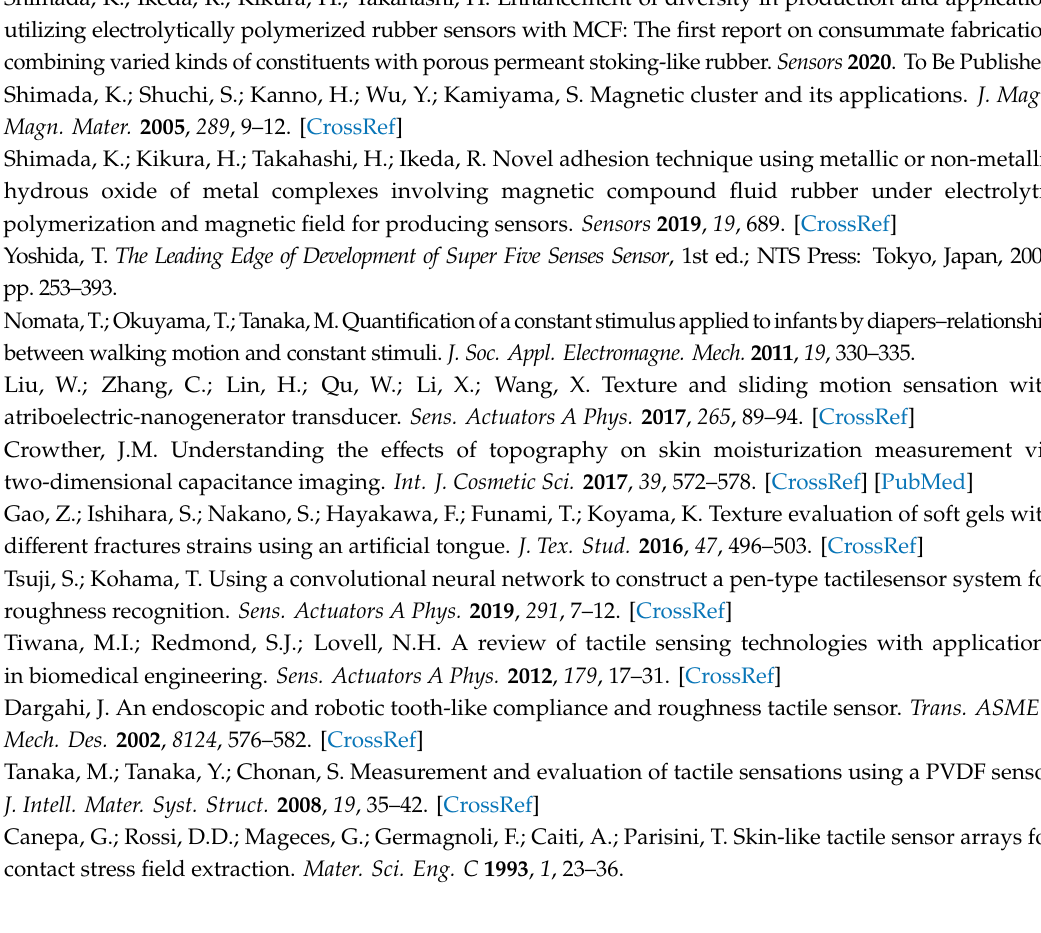
Figure A2. Schematic of the experimental apparatus used to investigate the electric characteristics in Figure A2. the SFE [20].